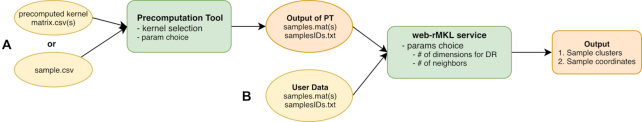
Workflow describing input and output of web-rMKL services. Yellow boxes represent input files provided by the user; orange is output generated by our services and in green our provided services. Two starting points are possible: (A) Offline: Several precomputed kernel matrices (CSV format) or feature files are input of the precomputation tool. Currently, the computation of RBF, polynomial and linear kernel are supported. The kernel parameters Gamma, Coefficient and Degree (depending on kernel choice) can be set. Output of the precomputation is a valid input for the online service. (B) Online: Direct upload of sample identifiers and kernel matrices (MAT format) is possible to use the rMKL-LPP service. The results are generated based on the choice of parameters and can be visualized online (for two and three dimensions). General output is two text files: 1) the learned cluster assignment for each sample, and 2) the coordinates of the sample projections.